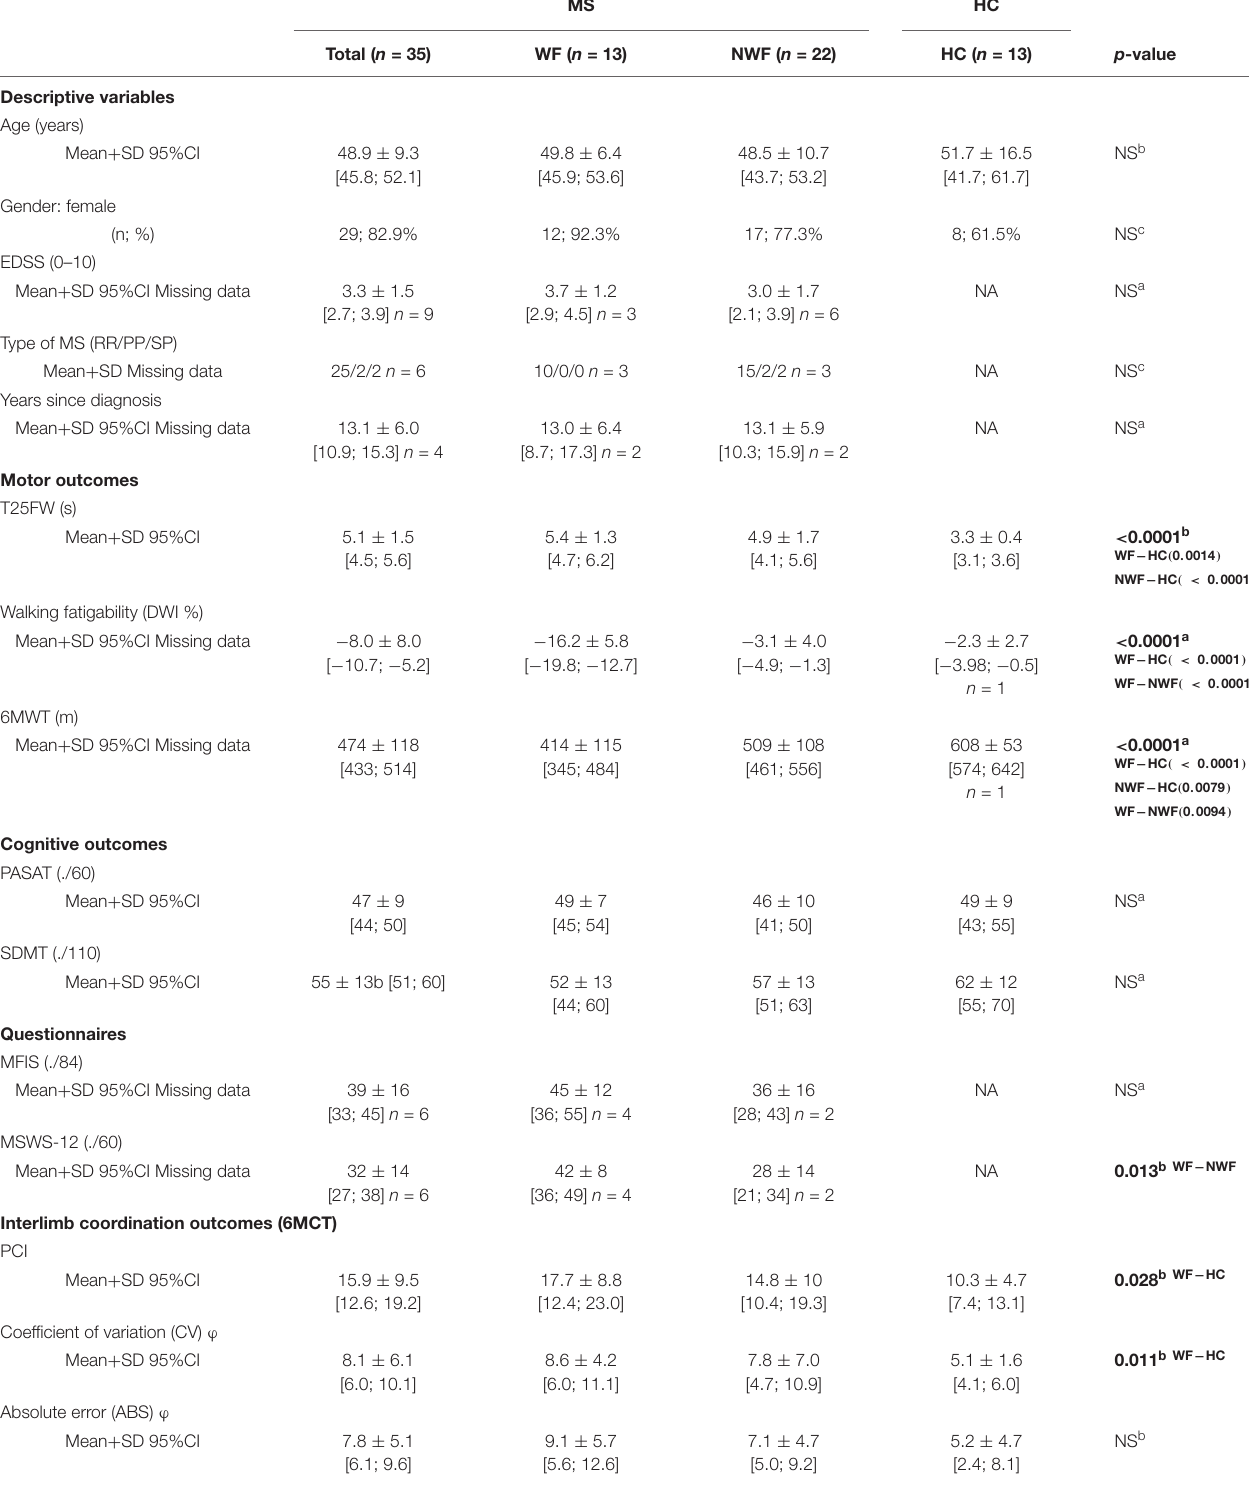
TABLE 1 | Descriptive, demographic characteristics and interlimb coordination outcomes (mean, standard deviation) in HC and pwMS